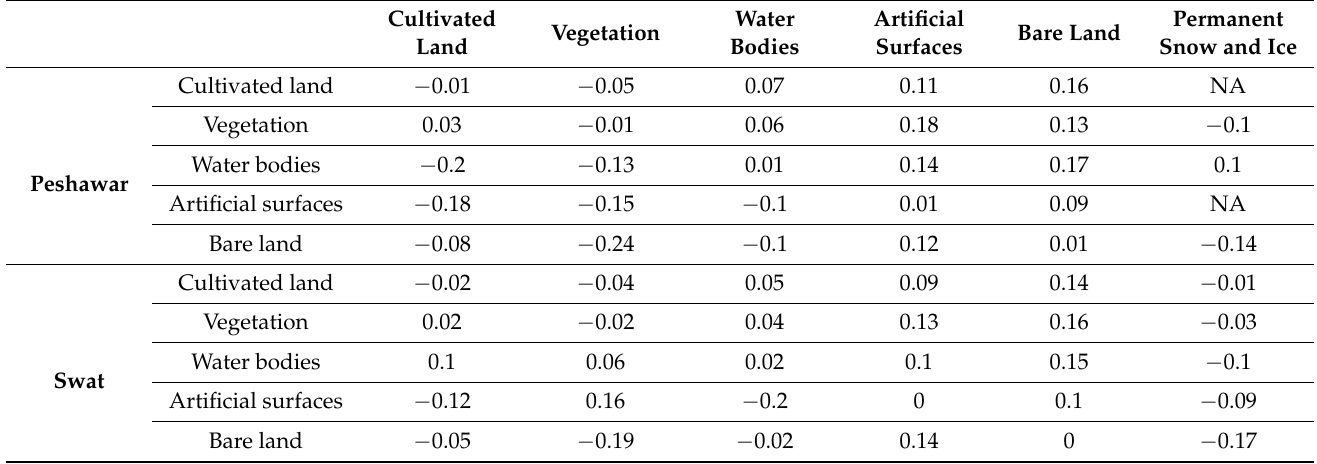
Table 5. CFLRM-based average contribution rate of LULC class transition to LST ( ◦ C) from 2000 to